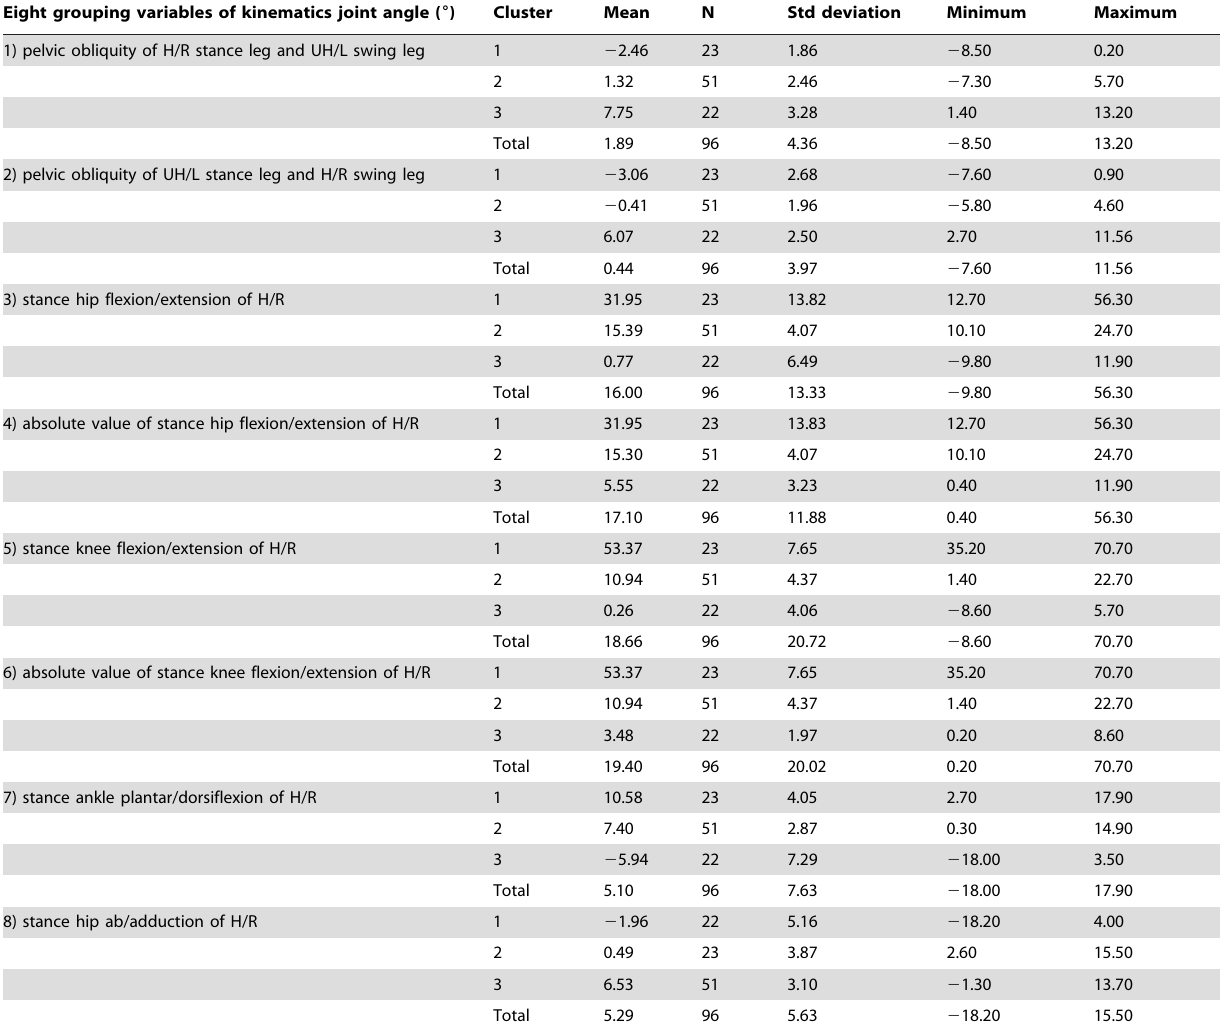
Eight grouping variables of kinematics joint angle ( 6 )